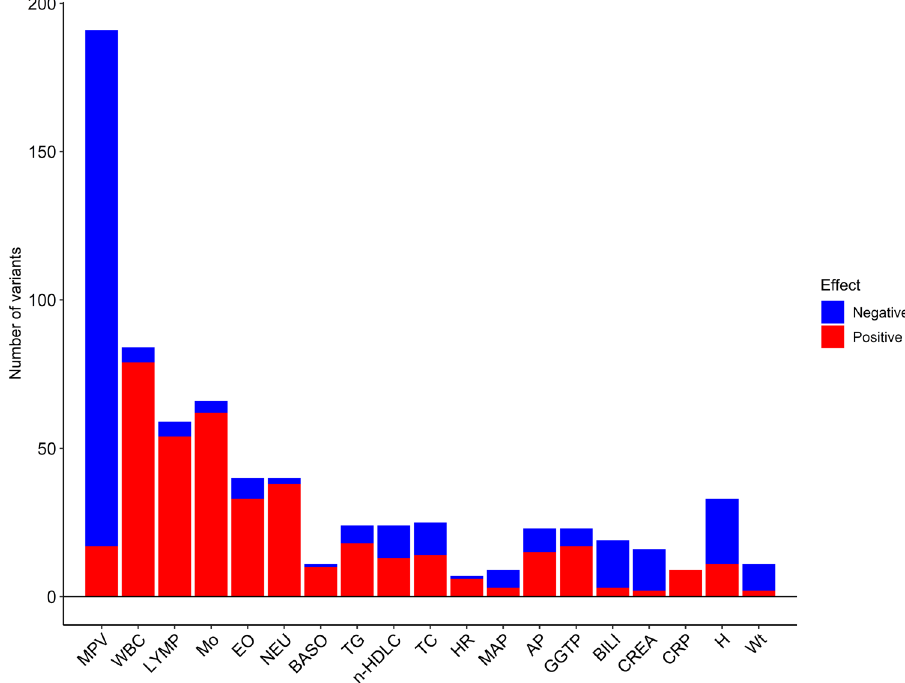
Fig. 1 Overview of association of the PLT variants with other quantitative traits. Data are presented with respect to the PLT increasing allele. Signi fi cance criteria: P value ≤ 3.6 × 10 − 6 ( “ Methods ” ). For details on associations, see Supplementary Data 6. AP alkaline phosphatase, BASO basophil count, BILI total bilirubin, CREA serum creatinine, CRP C-reactive protein, EO eosinophil count, GGTP gamma-glutamyl transpeptidase, H height, HR heart rate, LYMP lymphocyte count, MAP mean arterial pressure, Mo monocyte count, MPV mean platelet volume, n-HDLC non-HDL cholesterol, NEU neutrophil count, TC total cholesterol, TG triglycerides, WBC white blood cell count, Wt